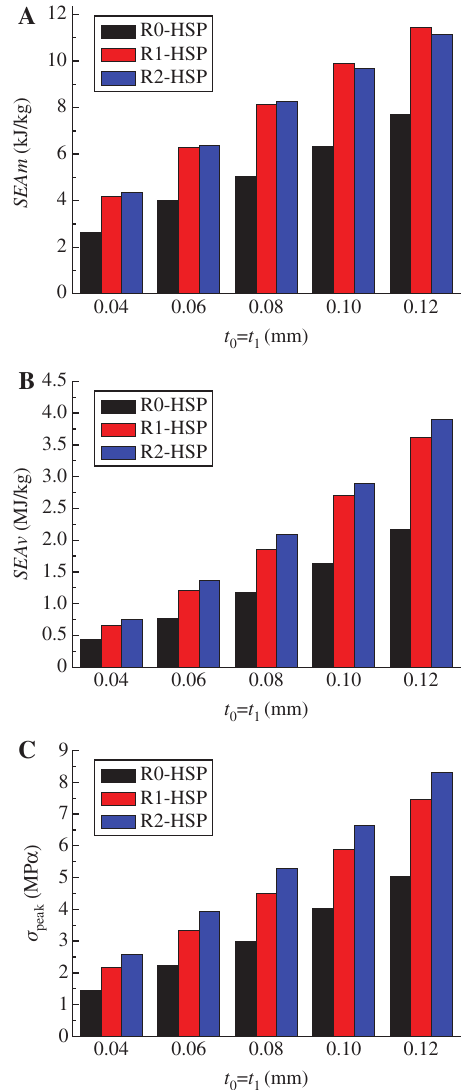
Figure 5: Comparison of crashworthiness indicators of the three HSP designs: (A) SEAm , (B) SEAv and (C) σ